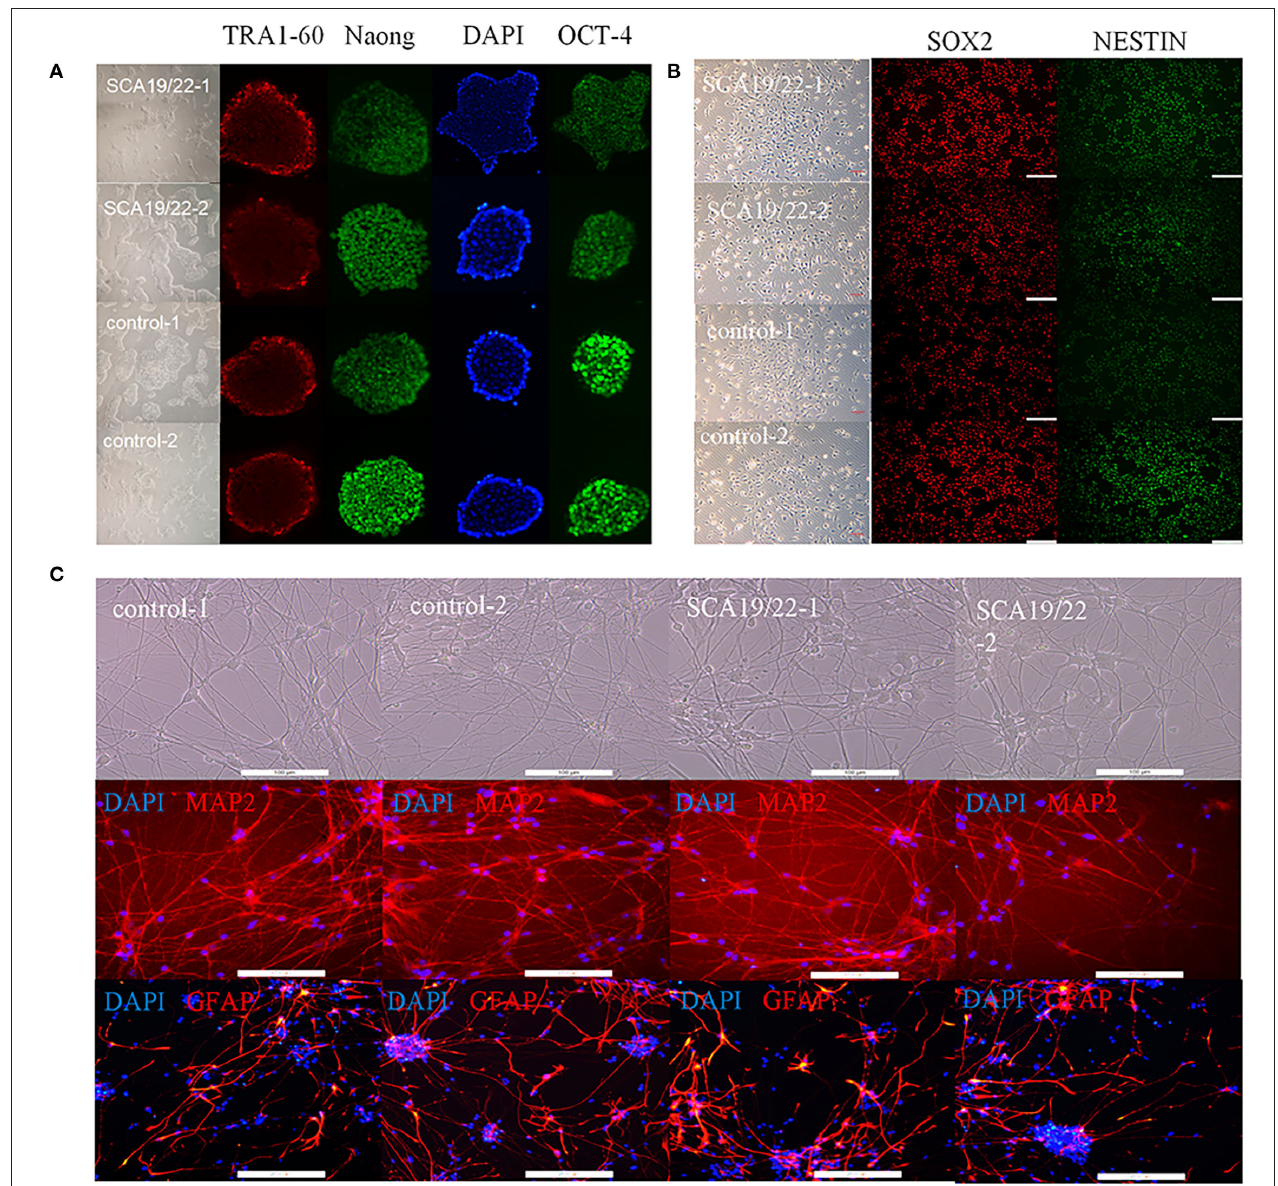
FIGURE 4 | Characterization of representative SCA19/22-iPSCs and control iPSCs. Immunostaining shows (A) pluripotency-associated markers in representative iPSC colonies; (B) NPC-expressed markers such as NESTIN1 and SOX2; (C) neuron-expressed markers such as GFAP and MAP2. Scale bar: 100 µ m for panels. iPSCs: induced pluripotent stem cells; NPC: neural progenitor